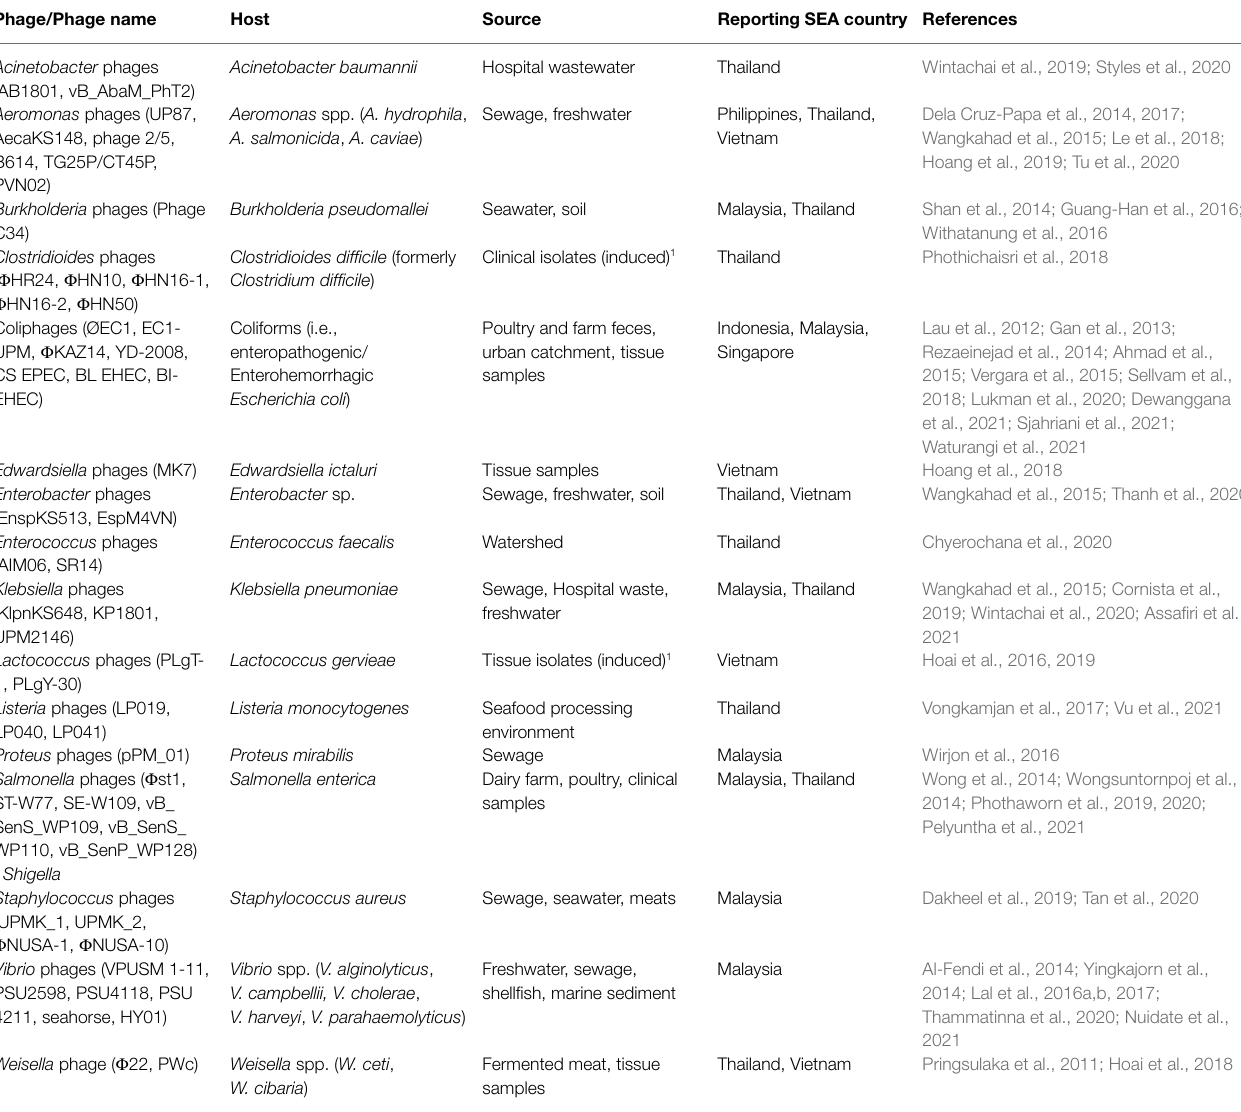
TABLE 2 | Phages with potential biomedical applications reported in SEA from 2011 to